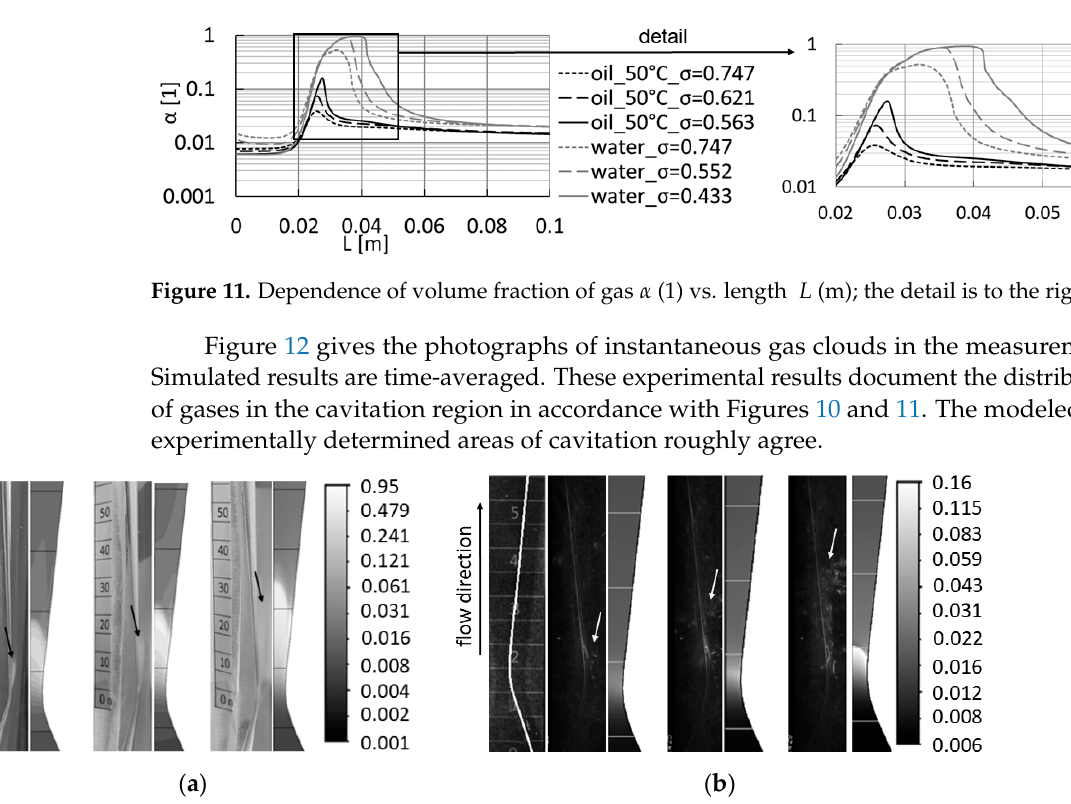
Figure 10. Dependence of pressure on the wall 𝑝 vs. length 𝐿 ; the detail is to the right. distribution of the volume fraction of gas evaluated on the nozzle wall during the water flow and the oil flow. The volume fraction of gas in water is significantly larger than in oil. In Figure 11, the average gas volume fraction in the constricted part of the nozzle is compared. For water, it is the sum of the average values of the vapor and air volume fractions (three-phase model) and for oil, only the average value of the air volume fraction (two-phase model).